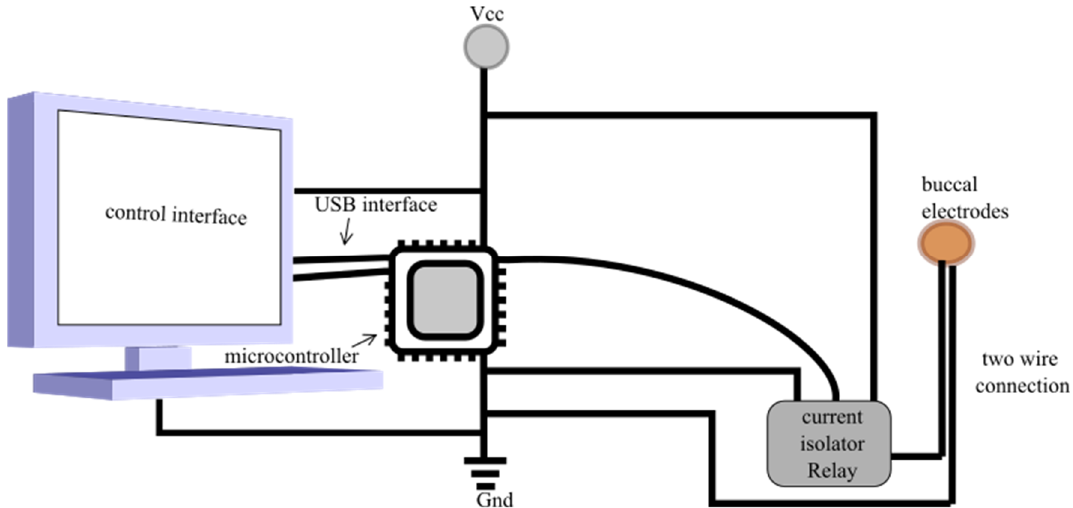
Figure 2. Real-time structure of the Buccal taste augmentation system.